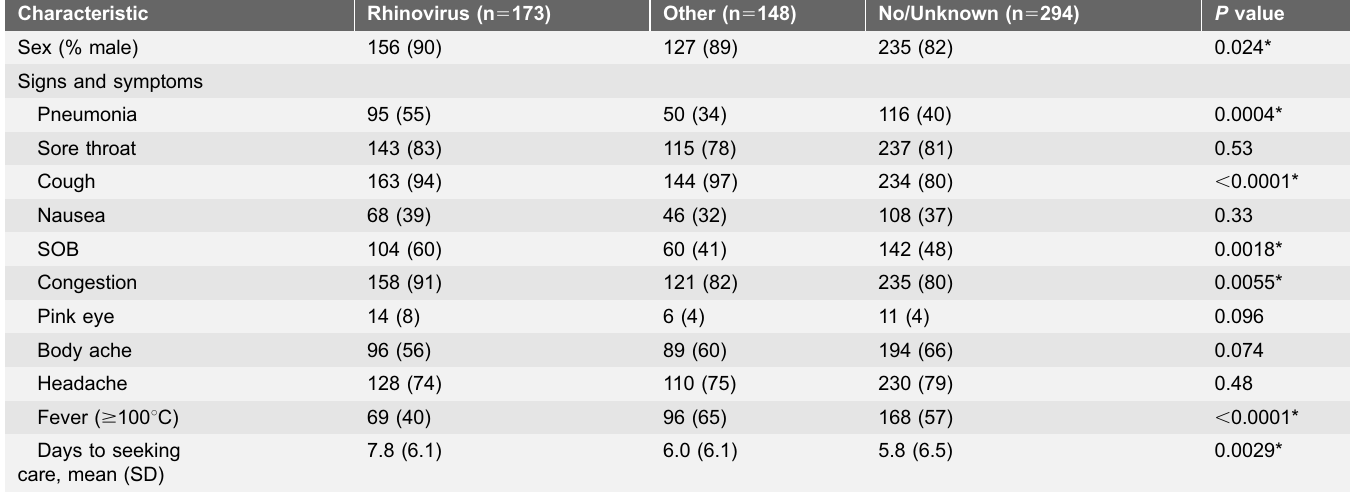
Table 3. Descriptive Characteristics by Rhinovirus, Other, and No/Unknown Pathogen among Military Recruits (n 5